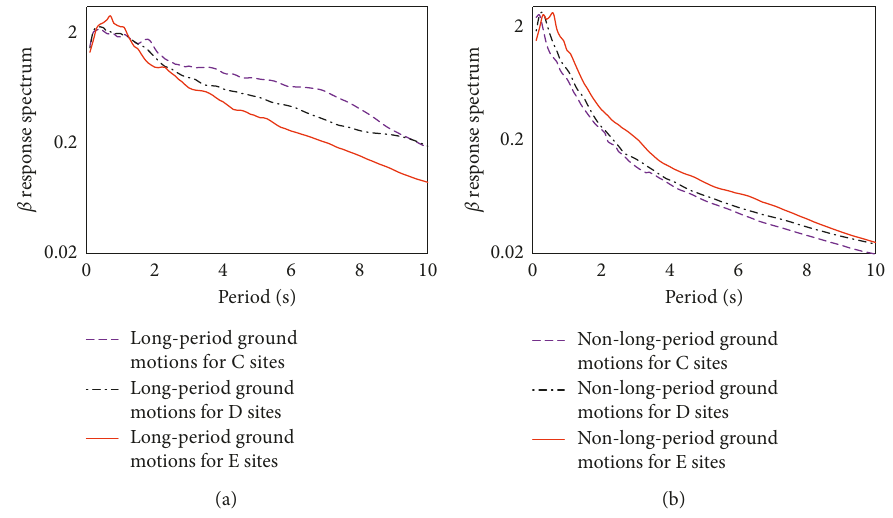
Figure 13: Mean normalized acceleration response spectra for long-period (a) and non-long-period (b) ground motions in terms of site